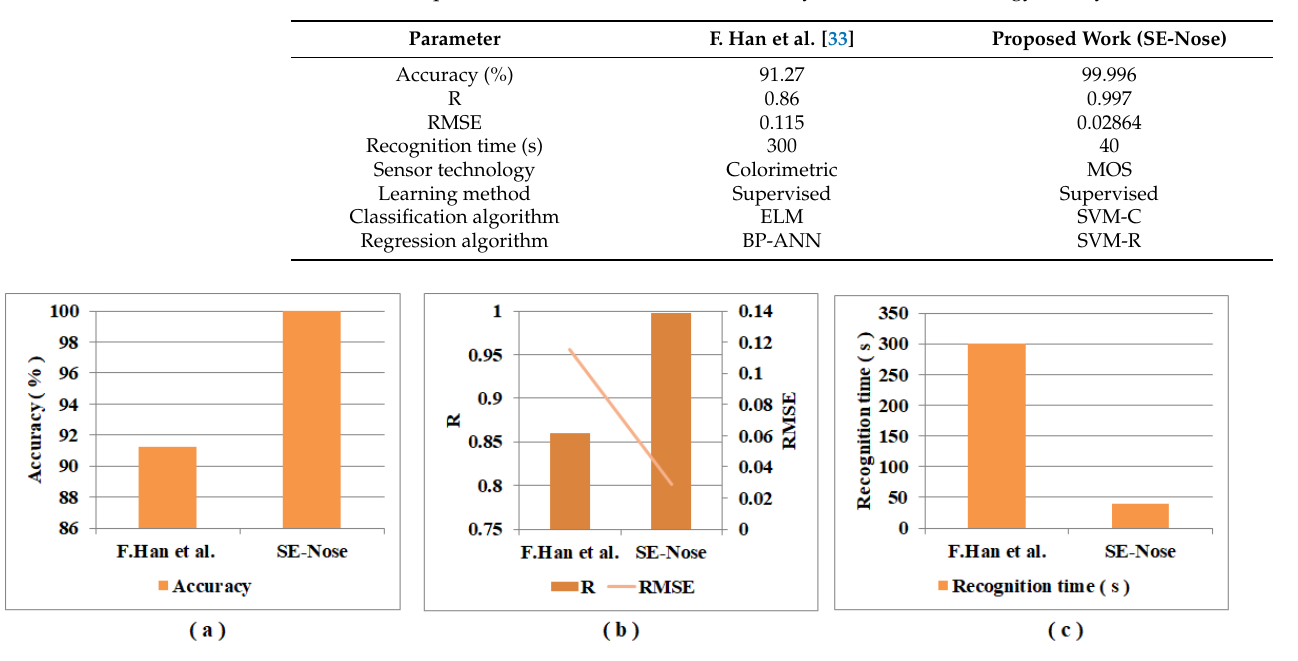
Table 11. Comparison between the results obtained by SE-Nose methodology and by F. Han et al. [33].